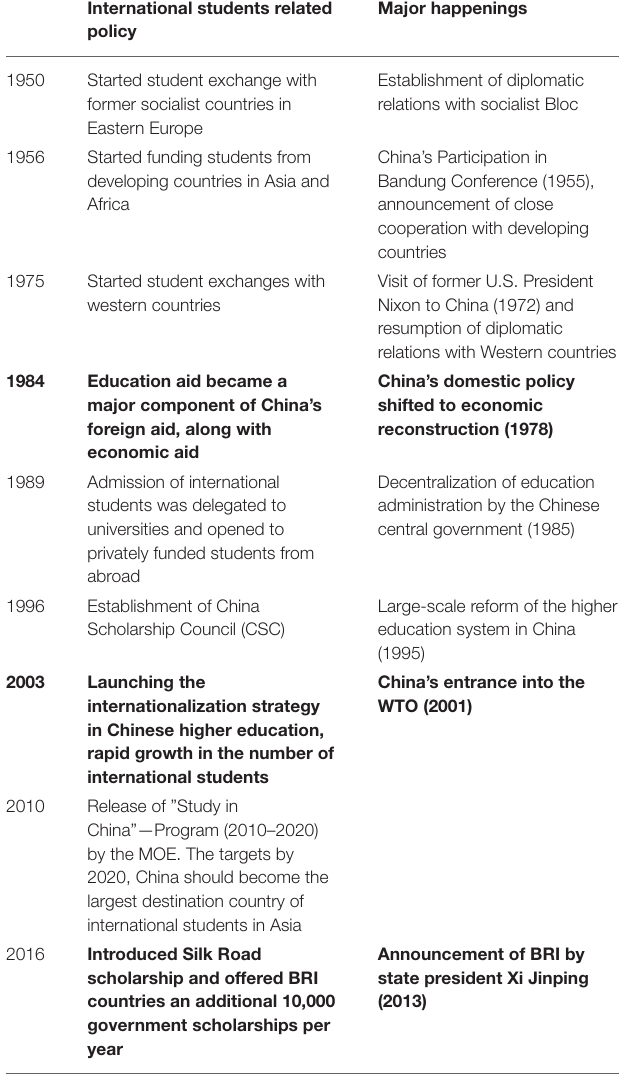
TABLE 1 | China’s policy on international